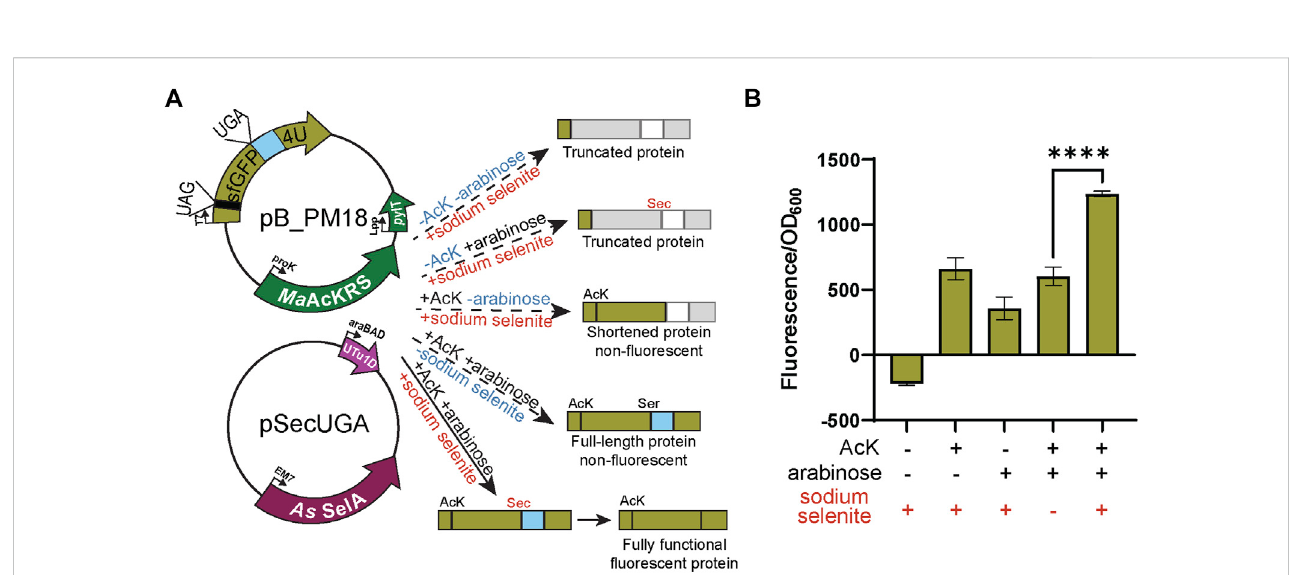
FIGURE 5 Con fi rmation of Sec insertion using intein reporter. (A) The assay was performed with a two-plasmid system: pB_PM15 and pSecUGA. The fi rst plasmid contains thegenesfor Ma AcKRS3-IPand tRNA Pyl CUA ( pylT )for insertion of N ε -acetyl- L -lysine (AcK) ataUAG and amodi fi edpB_04 sfGFPinteinreportergene. Thisgenehasbeenmodi fi edfromtheoriginal(Chungetal.,2022)toencodeaUAGatposition2andaUGAatposition204,the fi rstpositionoftheM86mini- intein. The second plasmid, pSecUGA, contains machinery for Sec insertion at UGA. In the presence of AcK, arabinose, and sodium selenite, the entire sfGFPgeneshouldbeexpressed.WhenSecisinsertedatposition204,theinteinwillsplice outtoproducea fl uorescentfunctionalreporter.Intheabsenceof sodium selenite alone, the entire sfGFP gene should be expressed except serine (Ser) should be inserted at position 204, which does not induce splicing. This results in a non-functional, non- fl uorescent protein. In the absence of AcK or arabinose (or both), translation stops resulting in truncated non- fl uorescent protein. Only the fi rst amino acid would be translated without AcK, while without arabinose, translation would stop at 204UGA. (B) The sfGFP_intein assay shows successful readthrough of position 2 and splicing of the intein in the presence of AcK, arabinose, and sodium selenite, with a signi fi cant increase in fl uorescence ( p < 0.0001) compared to when any one of the components is missing or in the absence of them all. Data are shown as the average of at least four biological replicates with the corresponding standard deviation shown with error